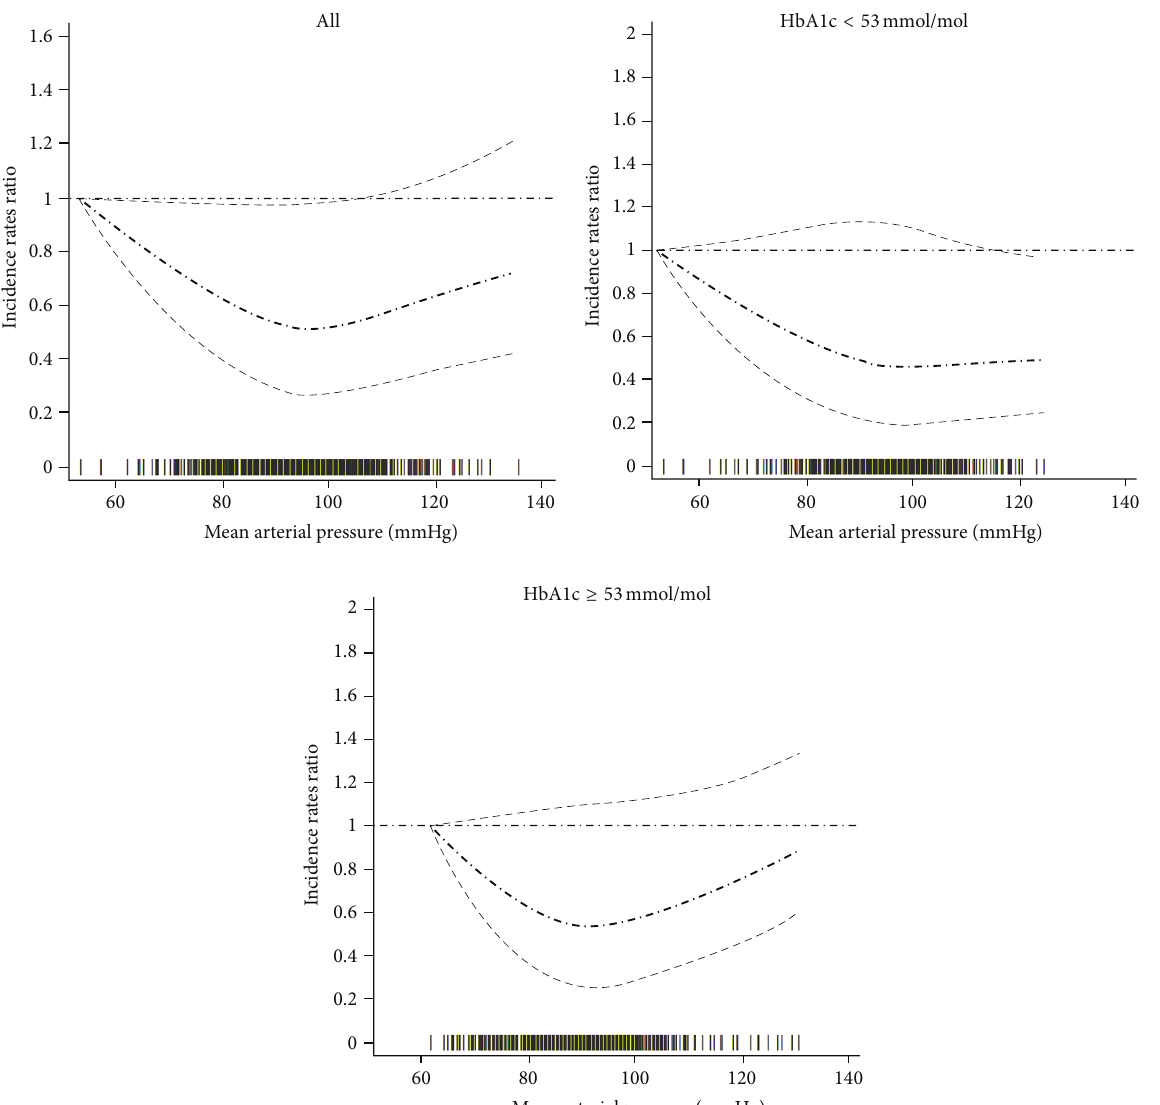
Figure 1: Relationship between mean arterial pressure and cardiovascular hospital admission: analysis in full data range. Adjusted for prevalent recorded history of cardiovascular/cerebrovascular disease, duration of diabetes registration in GP practices, body mass index, triglyceride, total cholesterol, low density lipoprotein, high density lipoprotein, estimated glomerular filtration rate, smoking status, lipid- lowering treatment, aspirin treatment, and pulse pressure. The thick dash-dot line indicates the incidence rate ratio and the thin dash line indicates the 95% confidence interval. The rag plot (bars on the 𝑥 -axis) presents the mean arterial pressure